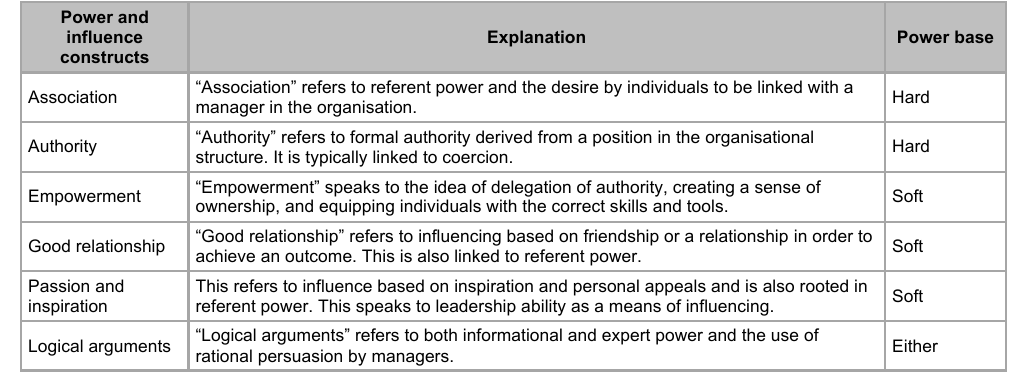
Power bases and influence tactics used in the